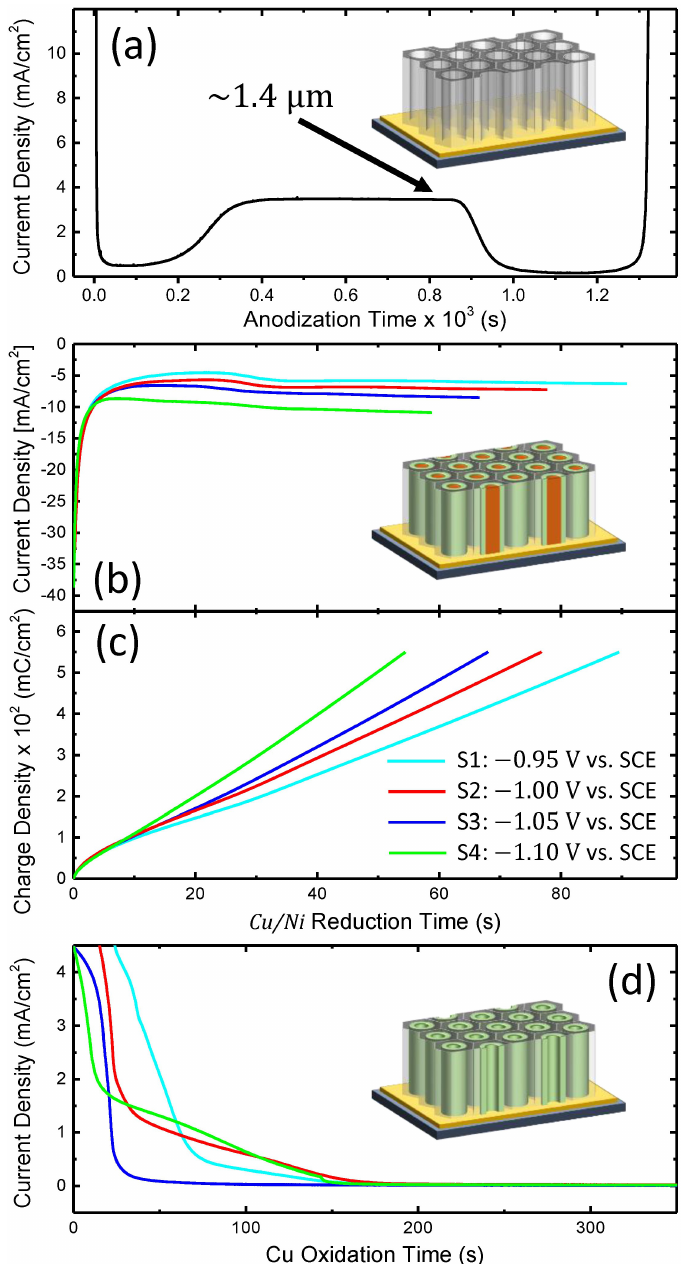
Figure 2. ( a ) Typical current curve obtained for the anodization of the entire Al film, to generate a supported AAO template with a thickness of ∼ 1400 nm. ( b ) Cathodic reduction current and ( c ) associated charge density obtained during the co-ECD of Cu/Ni core/shell NWs embedded within the supported AAO template, under various potentials applied versus a saturated calomel (SCE) reference electrode. ( d ) Corresponding anodic oxidation current curves for the electrochemical etching of the Cu cores. The insets show schematics of the three equivalent fabrication steps, as detailed in the